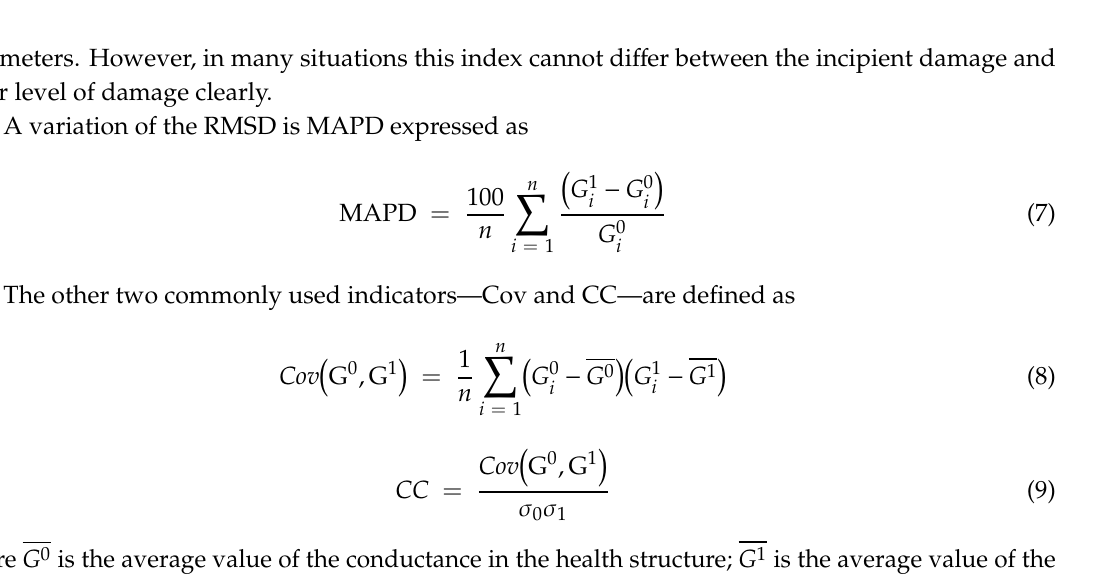
Table 3. Parameters of the PZT sensor.